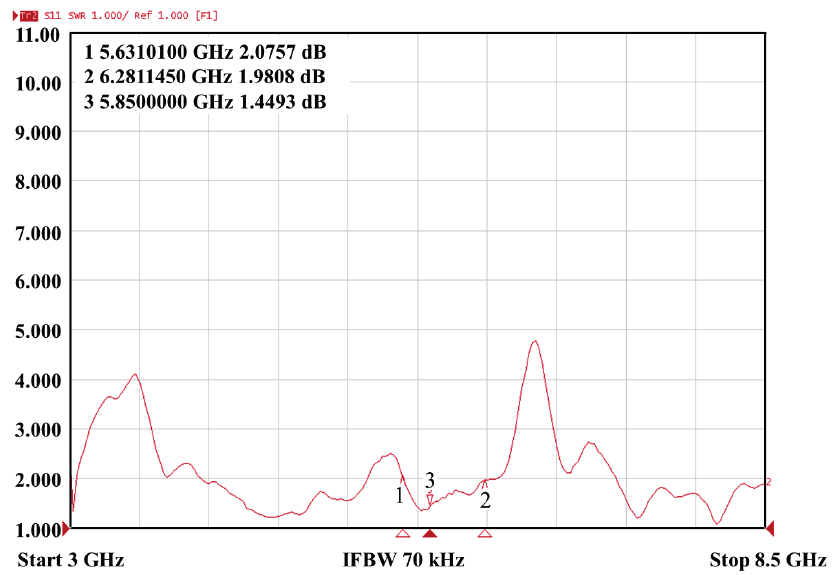
Figure 8. Measurement result of